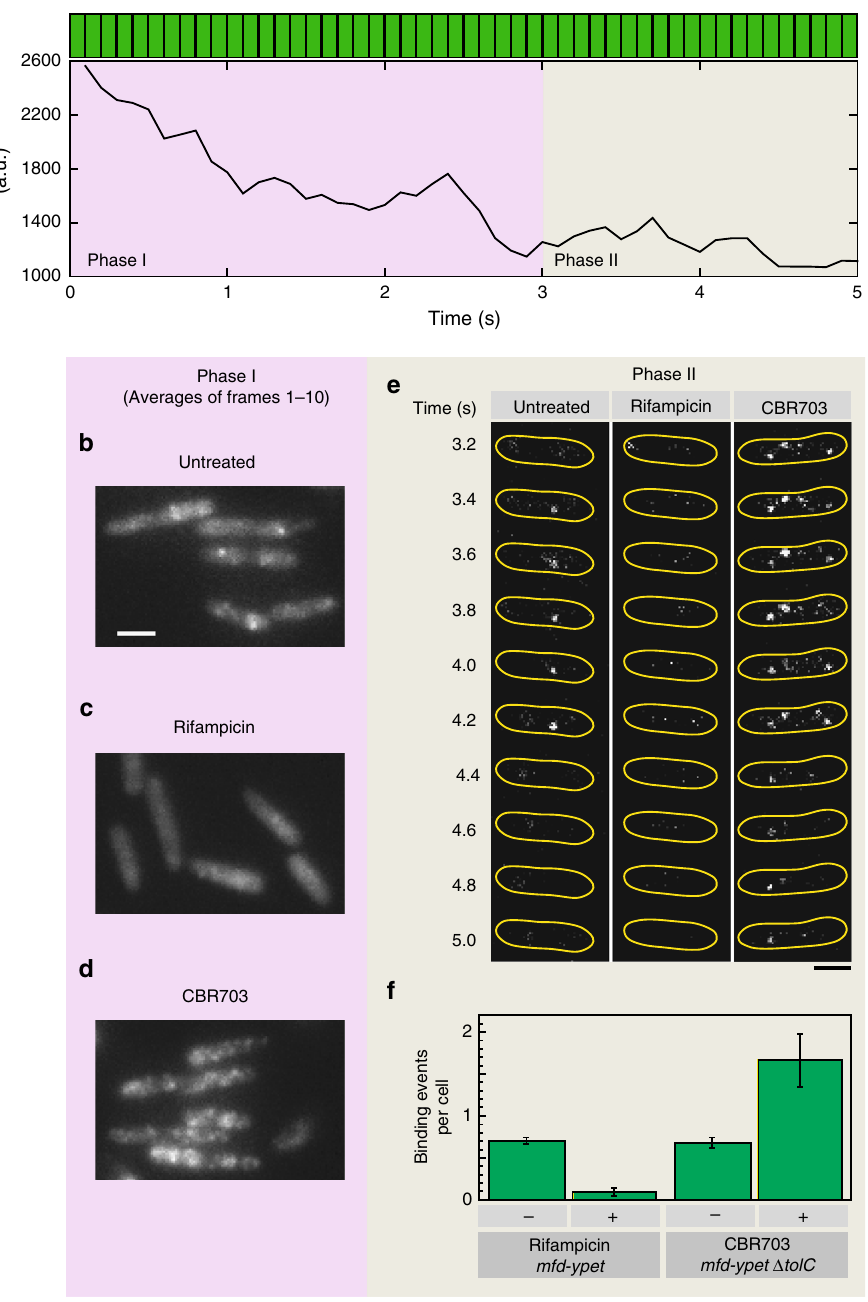
Fig. 3 Transcription inhibitors change Mfd-YPet binding frequency. a Mean cellular fl uorescence intensity of a representative single mfd-ypet cell during a 5-s continuous acquisition in 514-nm channel (each green bar (top) represents a 100-ms frame). To visualize single molecules of Mfd-YPet, the cellular fl uorescence was fi rst photobleached in a bleaching phase (Phase I; 3 s) followed by a photo-reactivation phase (Phase II; 2 s). Average projections of the fi rst ten frames in the bleaching phase (Phase I) of mfd-ypet cells b untreated or c rifampicin-treated (50 µ g per mL, 60 min) and d mfd-ypet Δ tolC cells with CBR703 treated (75 µ g per mL, 30 min). e Montage of 100-ms frames during photo-reactivation phase from an mfd-ypet cell (untreated) or treated with rifampicin, and an mfd-ypet Δ tolC cell treated with CBR703. f Bar plot representing the number of Mfd-YPet sub-second binding events detected in untreated mfd-ypet cells ( n = 1564 cells), cells treated with rifampicin ( n = 396 cells), mfd-ypet Δ tolC untreated ( n = 966 cells) and in CBR703 ( n = 598 cells). Error bars are standard deviations from three independent experiments for each condition. Scale bars, 2 µ